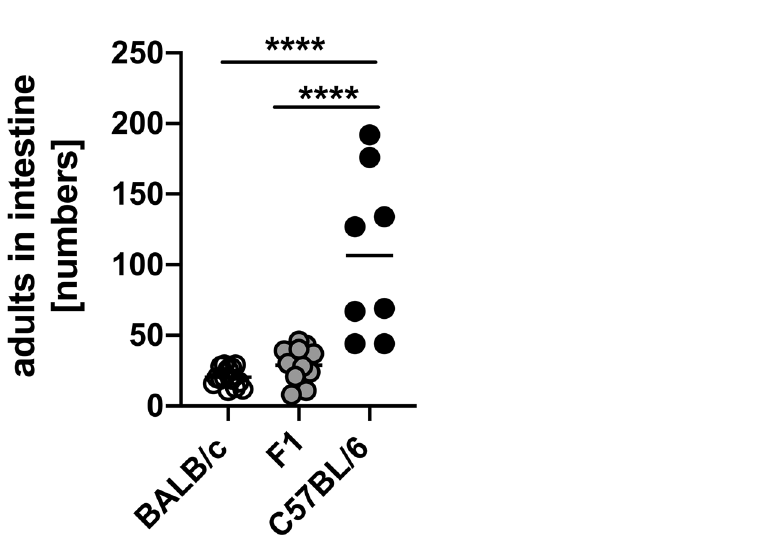
We observed a coexpression of the marker CTLA-4 with CD49b (Fig. 3, grey gate) or LAG-3 (Fig. 3, blue gate) in all mouse strains, while all other markers showed a patchy distribution. Expression of VISTA or PD-1 only par- tially overlapped with other markers. The majority of PD-1 + or VISTA + Treg did not coexpress CTLA-4, BTLA, LAG-3 or CD49b. Strikingly, Treg from C57BL/6 mice showed an increased expression of CTLA-4, CD49b and VISTA compared to Treg from F1 mice and even more pronounced compared to Treg from BALB/c mice, which was confirmed by statistical analysis (Fig. 4). The receptor TIM-3 was barely detectable (Supplementary Fig. 2b) and expression levels were similar by Treg from BALB/c, F1 and C57BL/6 mice (Fig. 3). Statistical analysis of Foxp3 + Treg showed the highest expression of CTLA-4 (Fig. 4a), BTLA high (Fig. 4b), CD49b (Fig. 4c), and VISTA (Fig. 4d) in C57BL/6 mice compared to BALB/c mice. Mes LN from F1 mice exhibited an intermediate phenotype or were similar to BALB/c mice at day 0 and day 6 p.i. Murine genotype or infection did not alter the expression level of LAG-3 by Treg (Fig. 4e). Surprisingly, the expression of PD-1 did not increase during infec- tion with S. ratti (Fig. 4f). Constitutive PD-1 expression was lowest in mes LN from F1 mice and significantly higher in Treg derived from S. ratti -infected BALB/c and C57BL/6 mice. Next, we analyzed the expression of ILT3 (gating strategy Supplementary Fig. 3). ILT3 expression by Foxp3 + Treg from C57BL/6 mice was already higher at steady state (day 0) (Fig. 4g). During infection ILT3 increased only slightly in C57BL/6 mice, but was significantly higher compared to infected BALB/c and F1 mice. By contrast, infection with S. ratti did not alter the ILT3 expression by Treg from BALB/c and F1 mice. T-SNE analysis from CD4 + Foxp3 − T cells revealed more pronounced differences in the expression levels of all checkpoint receptors between the three murine genotypes (Fig. 5a–c). We observed coexpression of the markers CD49b and LAG-3 (Fig. 5, grey gate) indicating the presence of Tr1 cells. CD49b + LAG3 + Tr1 cells were partially positive for CTLA-4 and BTLA (Fig. 5, grey gate). The majority of LAG-3 + Foxp3 − T cells did not coexpress CD49b (Fig. 5, blue gate). Cells with the highest BTLA expression coexpressed PD-1 and fractions were positive for LAG-3 and CTLA-4 (Fig. 5, blue gate). Foxp3 − T cells from all mouse strains were highly positive for VISTA. The expression of the markers TIM-3 and CD39 was low in BALB/c, F1 and C57BL/6 mice (Fig. 5 and Supple- mentary Fig. 2b). The statistical analysis confirmed that the expression of CTLA-4 (Fig. 6a), BTLA high (Fig. 6b), CD49b (Fig. 6c), LAG-3 (Fig. 6d), and PD-1 (Fig. 6e) was highest in C57BL/6 mice and lowest in BALB/c mice. Foxp3 − T cells from F1 mice had intermediate expression levels of these markers. VISTA expression was similar in all mouse strains and was not upregulated compared to non-infected control mice (Fig. 6f). As shown for Foxp3 + Treg (Fig. 4g) ILT3 expression by Foxp3 − T cells from C57BL/6 mice was already higher at steady state (Fig. 6g) compared to BALB/c mice and by trend to F1 mice. The expression of ILT3 increased during infection in C57BL/6 mice and was significantly higher compared to infected BALB/c and F1 mice while the expression remained unchanged by Foxp3 − T cells from BALB/c and F1 mice.